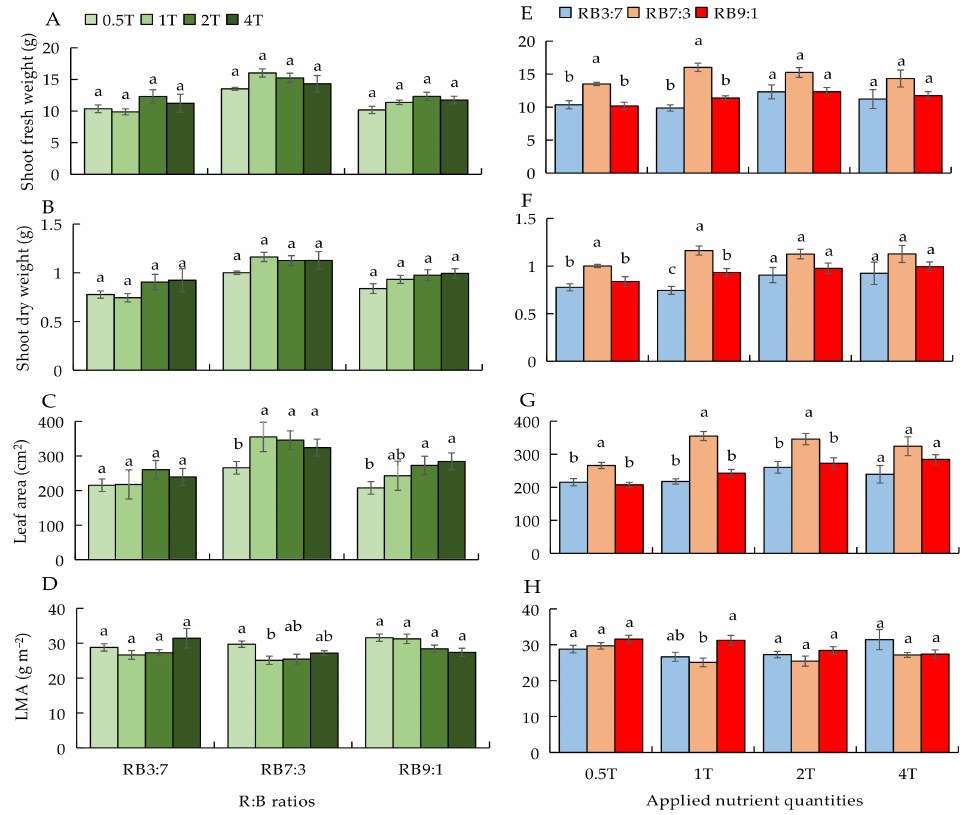
Figure 2. Shoot fresh ( A , E ) and dry weights ( B , F ), leaf area ( C , G ), and leaf dry mass per area (LMA) ( D , H ) at 20 days after transplanting under different ANQ treatments and R:B ratios. 0.5T, 1T, 2T, and 4T represent 4 different ANQ treatments, respectively. RB3:7, RB7:3, and RB9:1 represent R:B ratios of 3:7, 7:3, and 9:1, respectively. The error bars represent SEs (n = 6). Based on Tukey’s new multiple range test at p < 0.05. Different lowercase letters represent significant differences among different